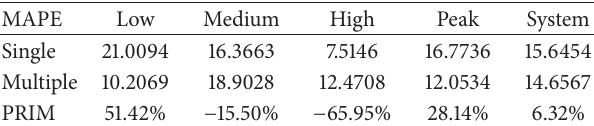
Table 6: Performance evaluation results of MAPE between the single and the two-stage multiple SVM in June 2010.